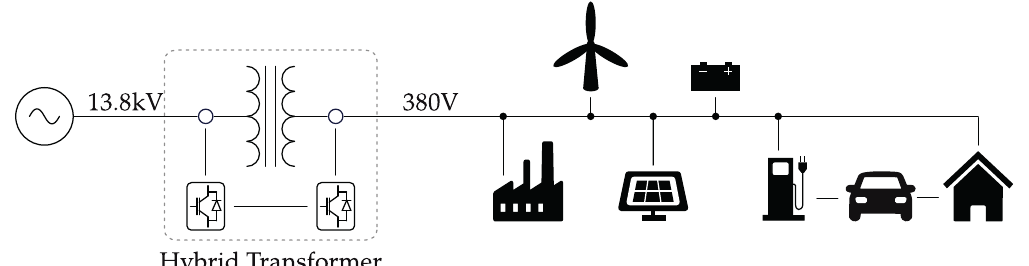
Figure 1. Hybrid distribution transformer (HDT)